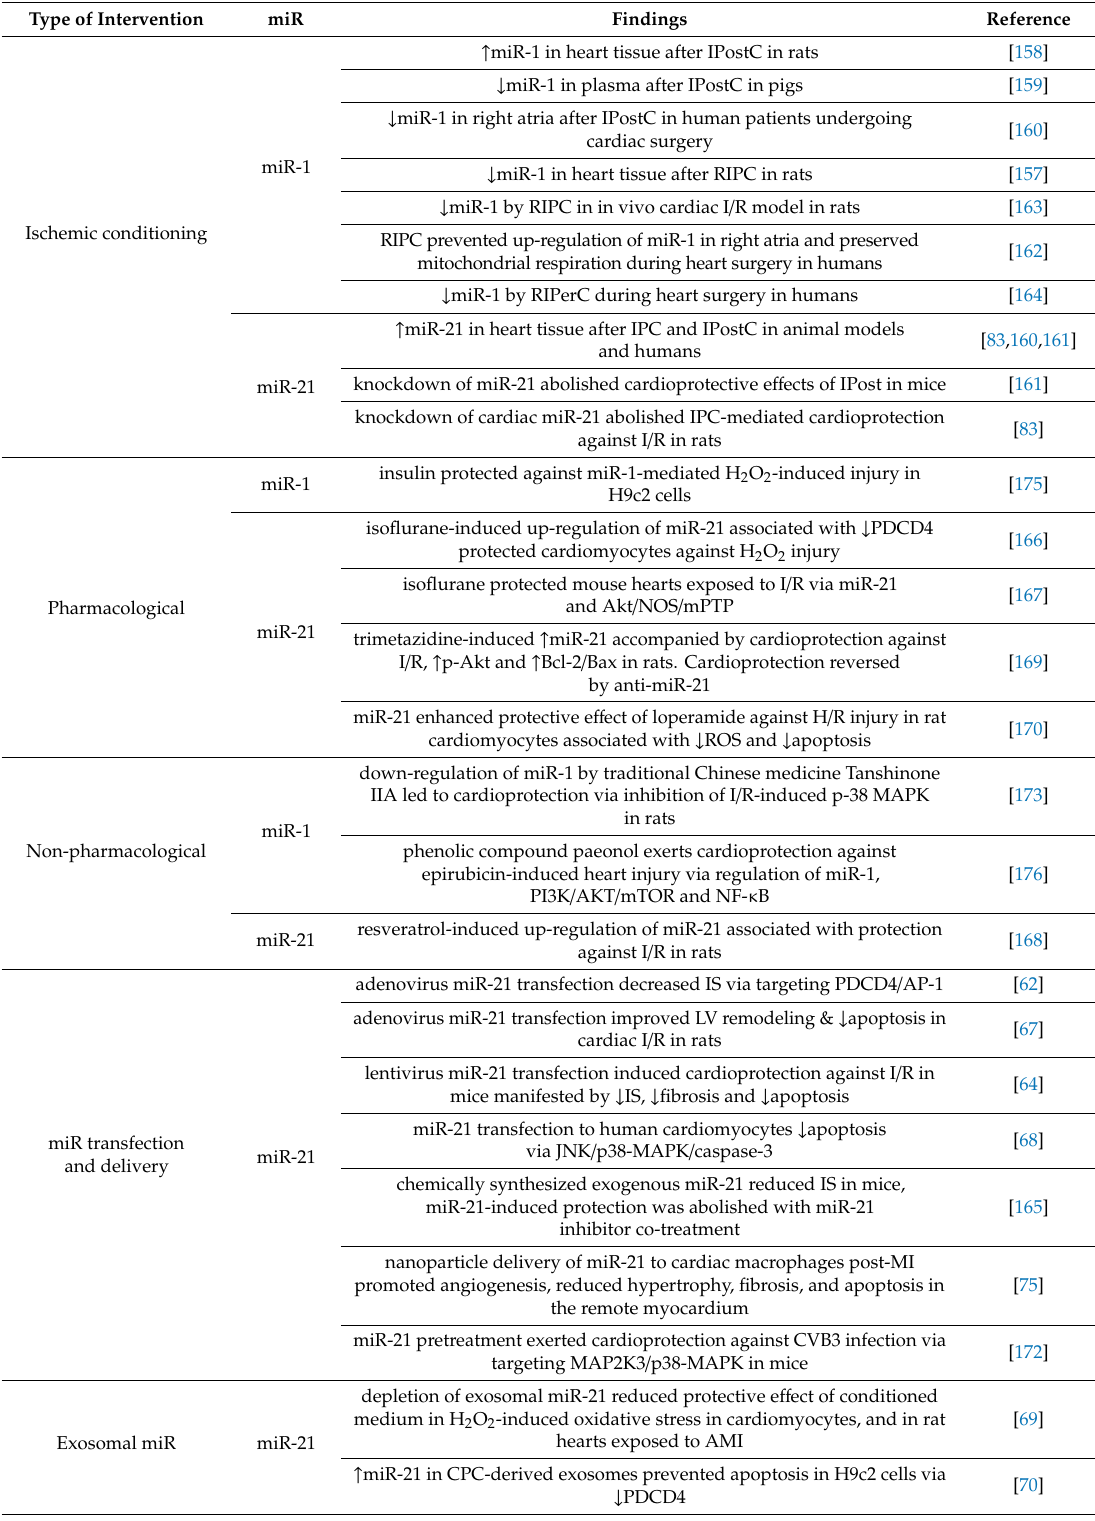
Table 2. Role of miR-1 and miR-21 in